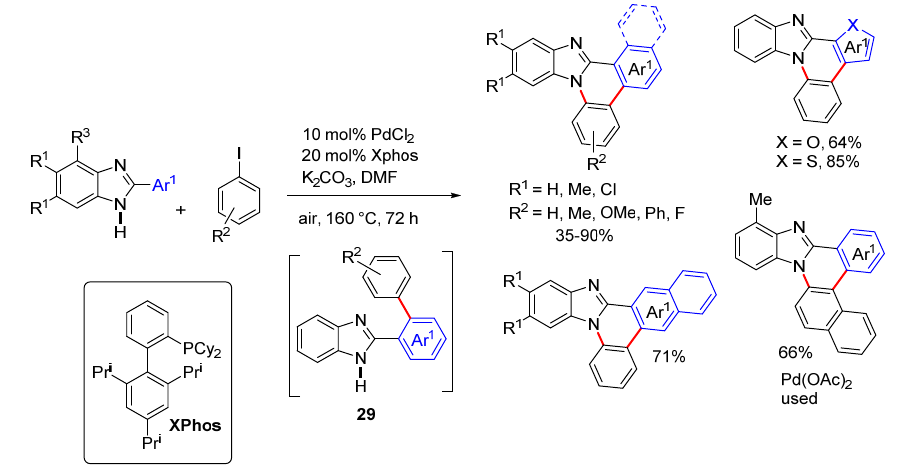
Scheme 27. Pd(II)-catalyzed synthesis of benzimidazole-fused phenanthridines [88].